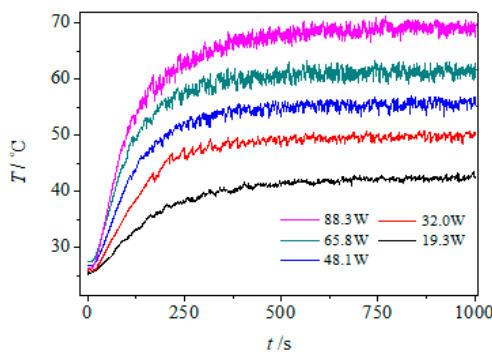
Figure 6. Effect of heat input on the temperature of the center point on evaporator surface.